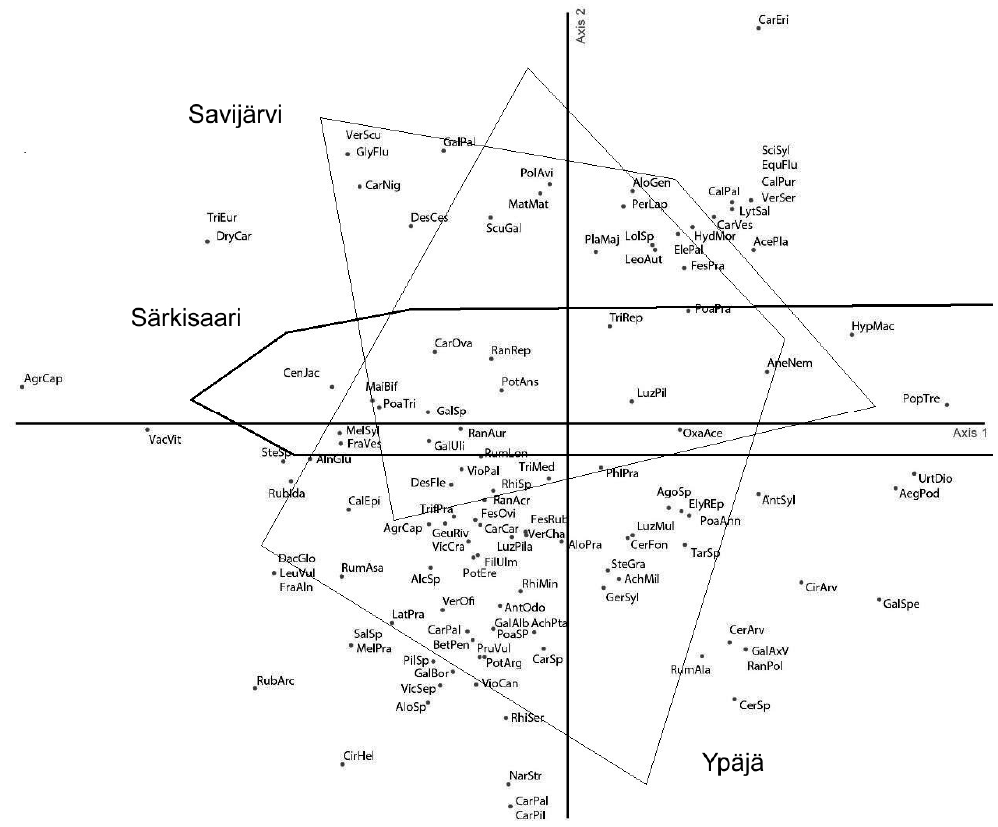
Figure 2. NDMS-ordination based on species composition in 1 m 2 sampling squares on the three horse pastures ( n = 86). The envelopes illustrate the levels of similarity between the study areas. Species names are abbreviated by the three first letters of genus and species names (see Supplementary material).